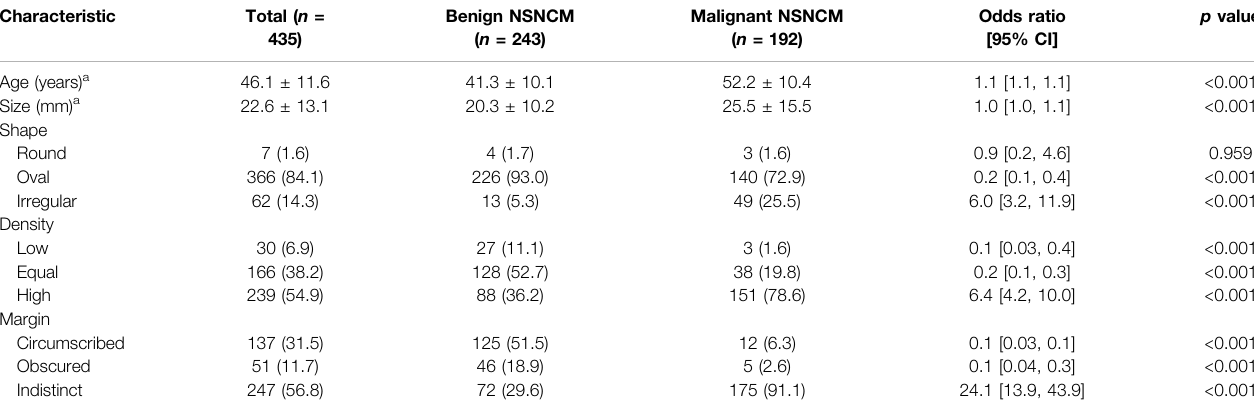
TABLE 1 | Univariate analysis of tumor signs and age between benign and malignant NSNCMs.